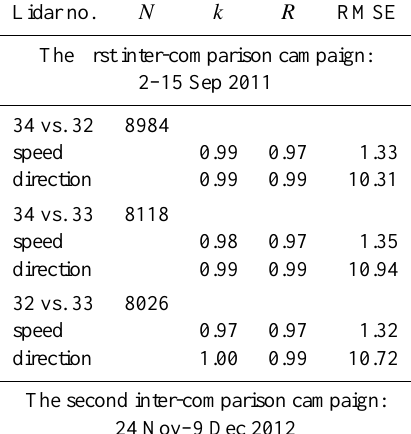
Table 4. Statistical comparison of wind speed and wind direction measured with Doppler lidars. Shown are number of samples ( N ), root mean square error (RMSE), Pearson correlation ( r ) and slope of fitted linear curve ( k ). Data averaged over 15min at range gates between 150 and 1050m were included in the respective sample here. Episodes of snow, rain, cloud and wind direction change larger than 50 ◦ between subsequent profiles were excluded from the anal- ysis here. Lidar no. N